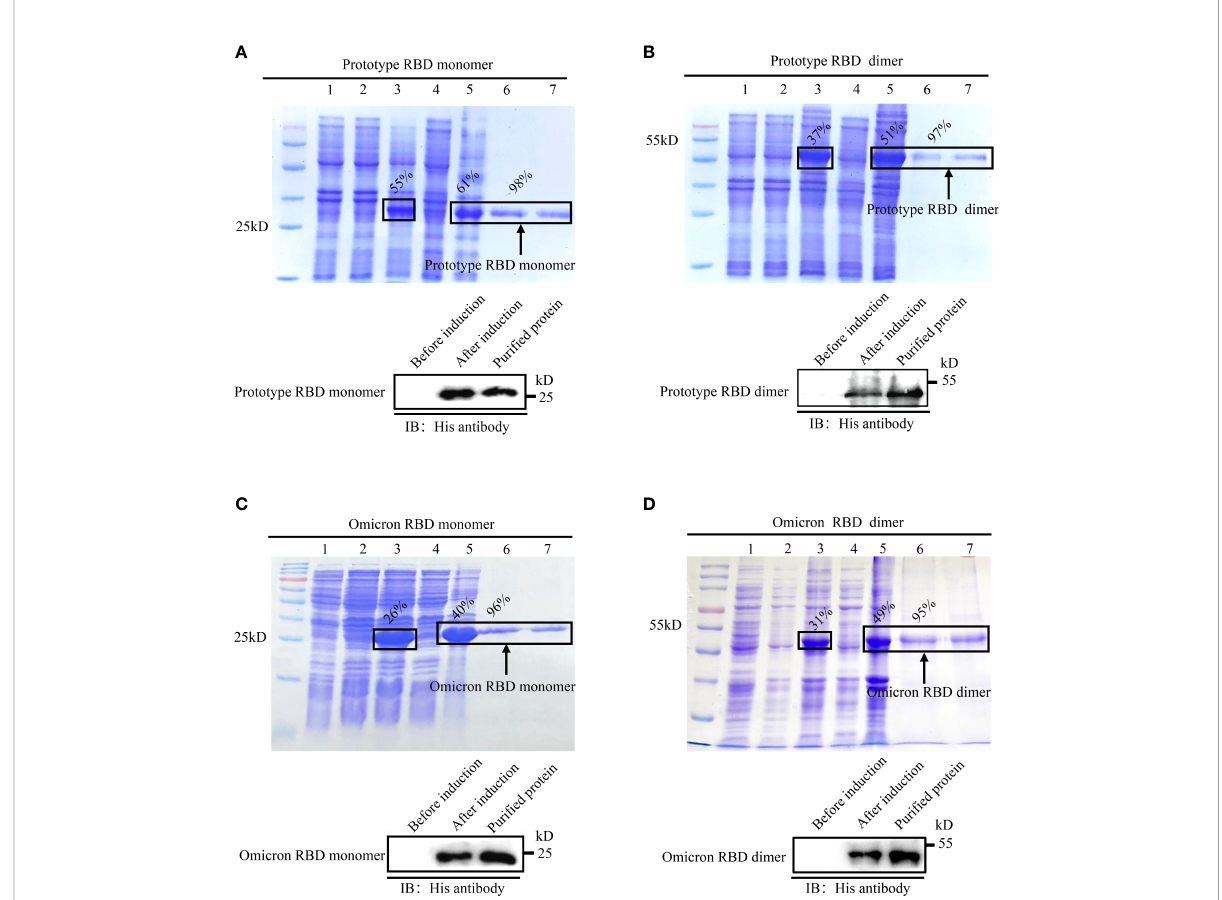
FIGURE 1 Expression, puri fi cation, and identi fi cation of recombinant spike RBDs. Recombinant pET-28a vectors expressing either monomeric or dimeric spike RBDs for prototype SARS-CoV-2 (A, B) and Omicron variant (C, D) were used to express the recombinant proteins in E. coli. The expressions and purities of RBDs were examined by SDS-PAGE (A-D, top) or immunoblotting ( A – D , bottom). (A-D) Top: M: protein marker; lane 1: empty vector; lane 2: un-induced sample; lanes 3 – 5: IPTG induced whole-cell lysate (lane 3); cellular supernatant (lane 4); inclusion body (lane 5); lanes 6 – 7 (A-D): puri fi ed monomeric (A, C) or dimeric (B, D) RBDs in eluted buffer with 250 mM imidazole. (A-D) Bottom: identi fi cation of spike RBDs by immunoblotting with anti-His tag